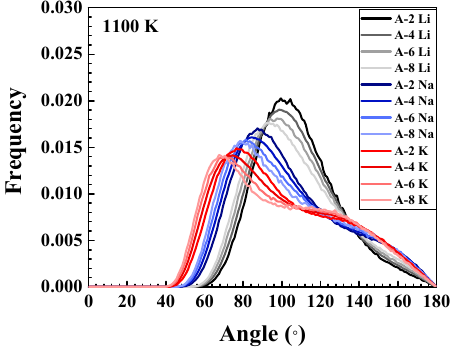
Figure 5. Angular distribution function (ADF) samples of Cl-A-Cl of four typical systems at 1100 K.